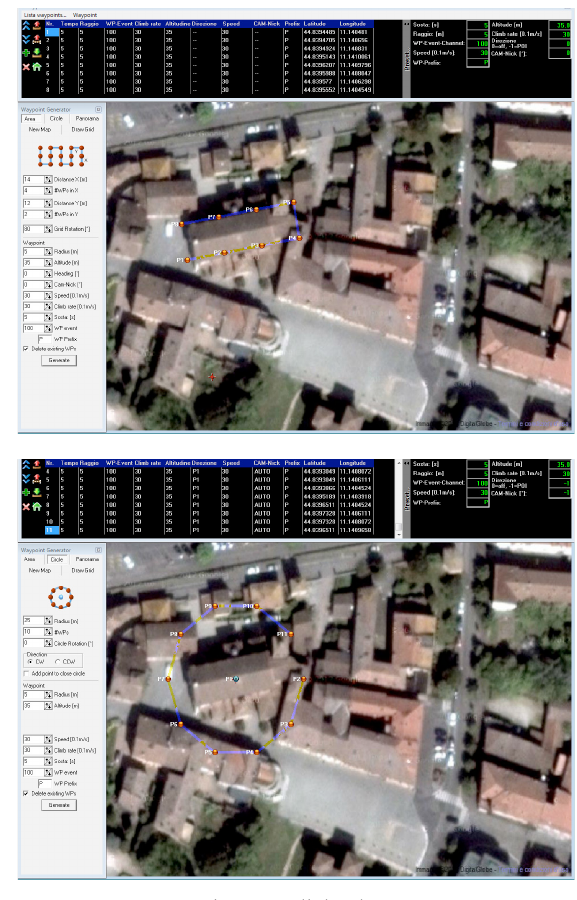
Figure 9: Flight